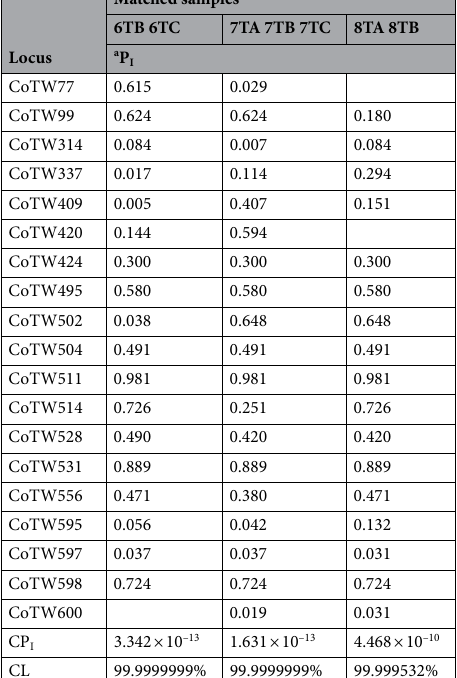
Table 6. individual P I and CP I of four matched groups. P I probability of identity, CP I combined probability of identity, CL confidence levels. a Database: 96 C. taiwanensis individuals. Markers failed in PCR amplification or their peak heights smaller than RFU150 in typing were not subjected into P I calculation and are shown in blank. 6TB, 7TA, 7TB and 8TA are victim tree. 6TC, 7TC, 8 TB are seized